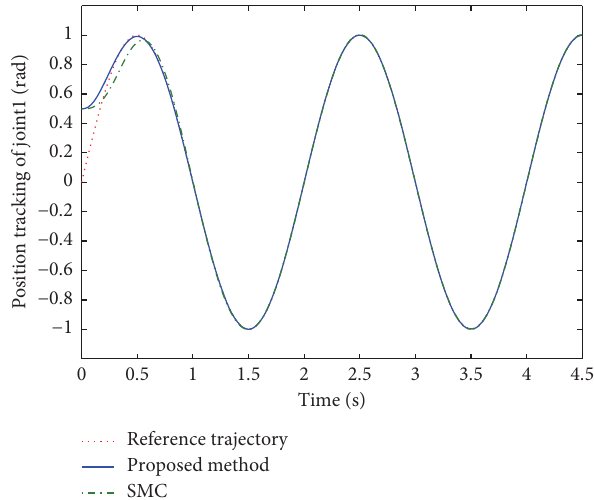
Figure 3: Asynchronous multirate sensor measurements.